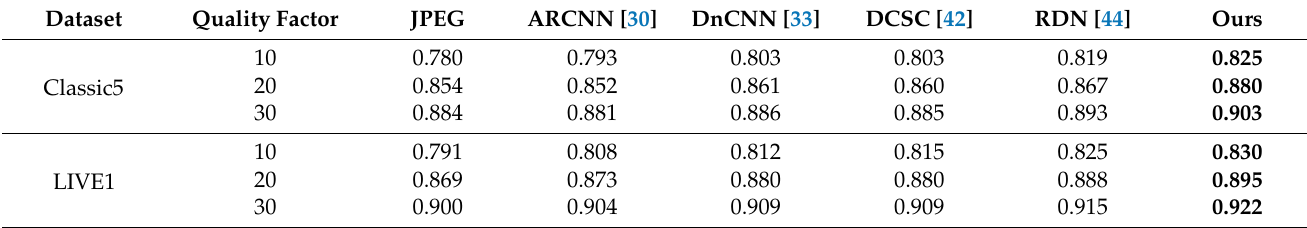
Table 7. SSIM comparisons on the test datasets. The best results of dataset are shown in bold. Dataset